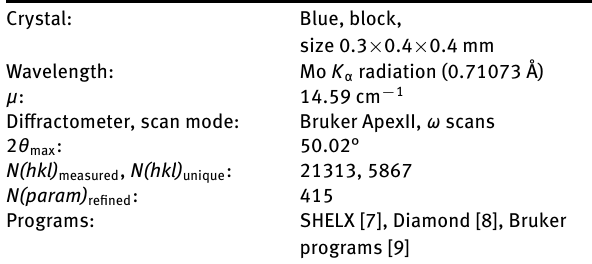
Table 2: Fractional atomic coordinates and isotropic or